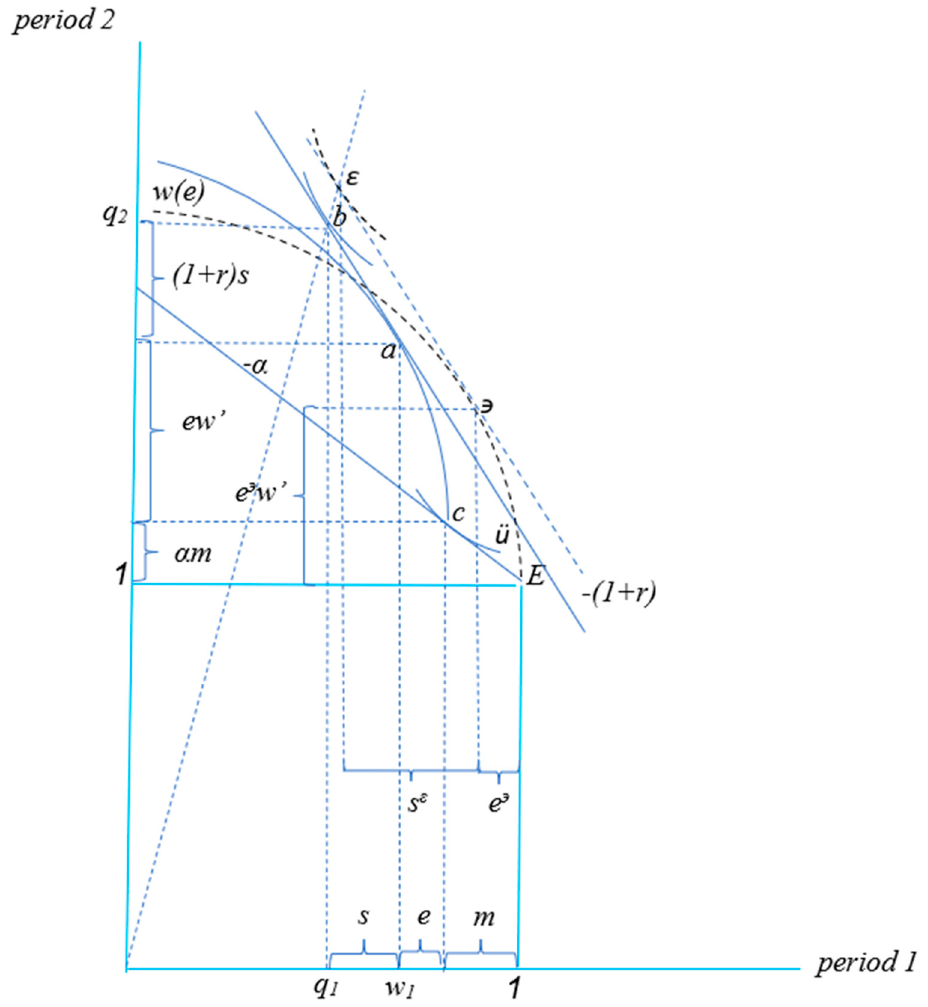
Figure 2. Life-cycle optimization with education and cash insurance.